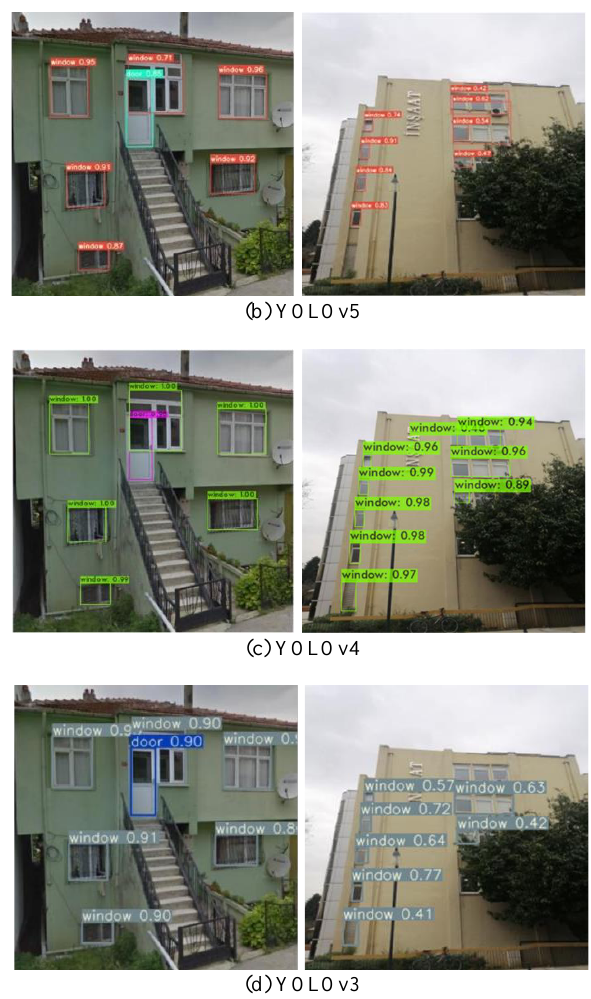
Figure 5 . Result image for each